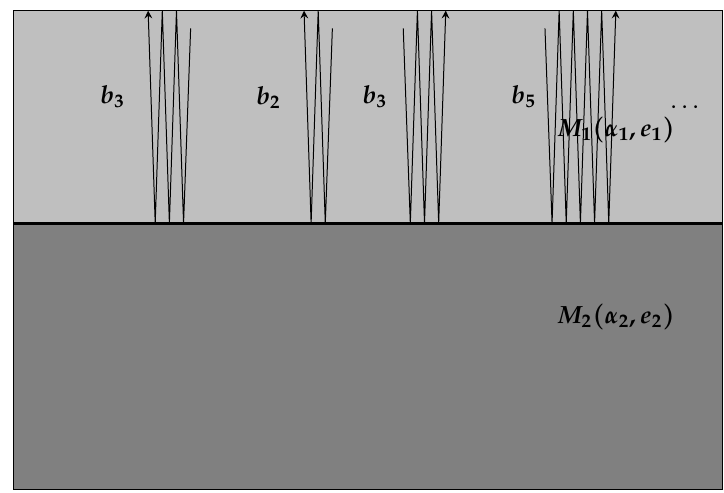
Figure 6. Waves that are reflected first at the interface between M 1 and M 2